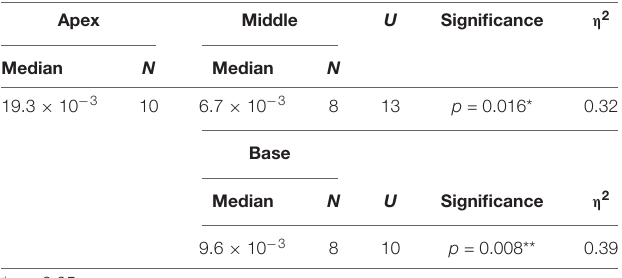
TABLE 4 | Relative expression of SCN8A in apex compared to base and middle of cochlea at 12–13 WG. Apex Middle U Significance η 2